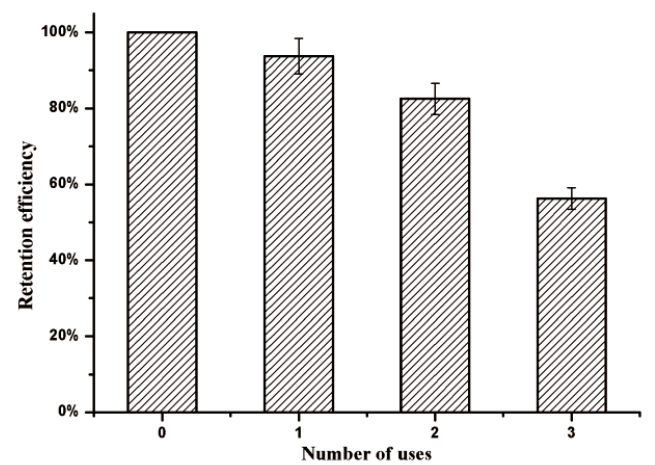
Figure 7. Retention efficiency of magnetic immobilized enzyme after three usage cycles.